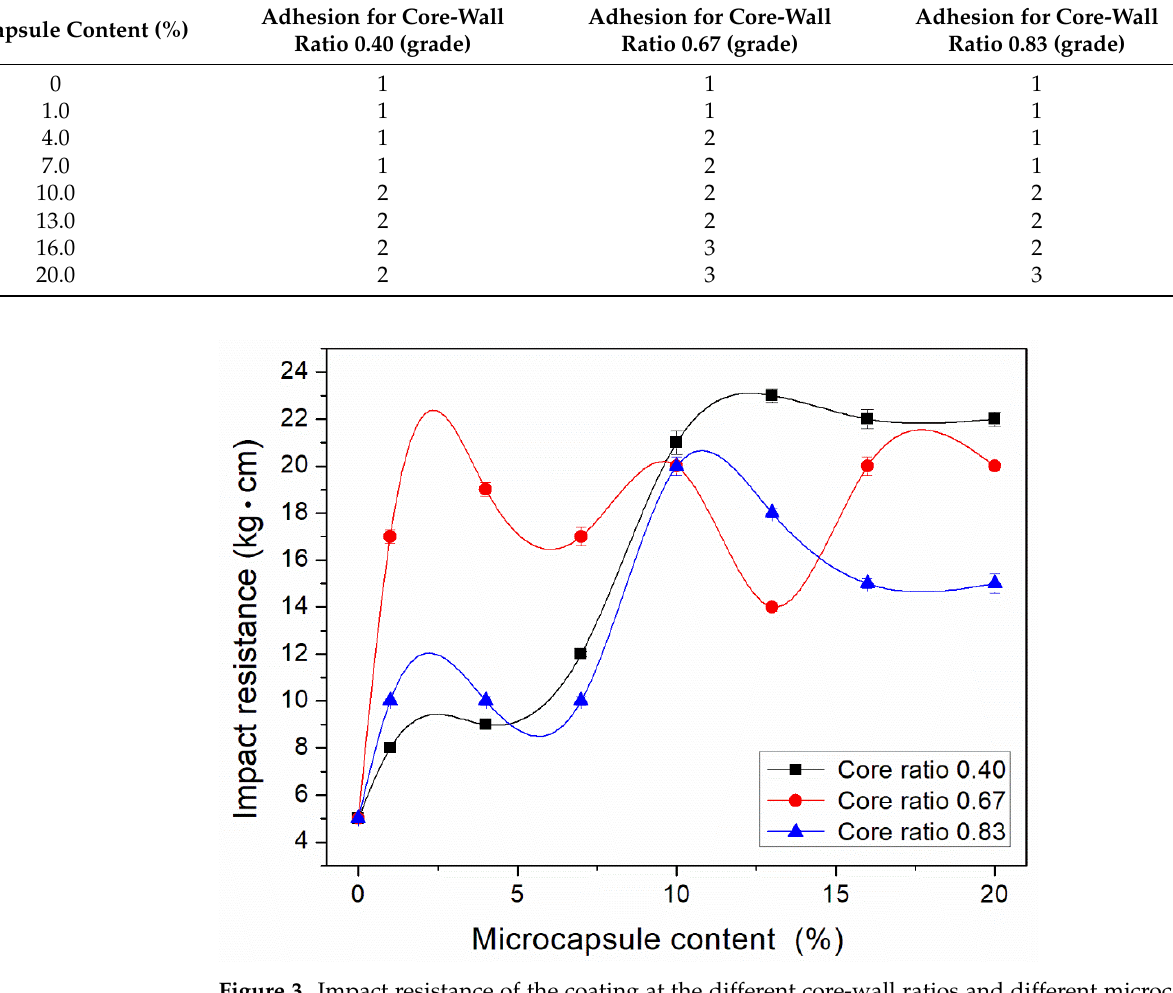
Figure 3. Impact resistance of the coating at the different core-wall ratios and different microcapsule content.